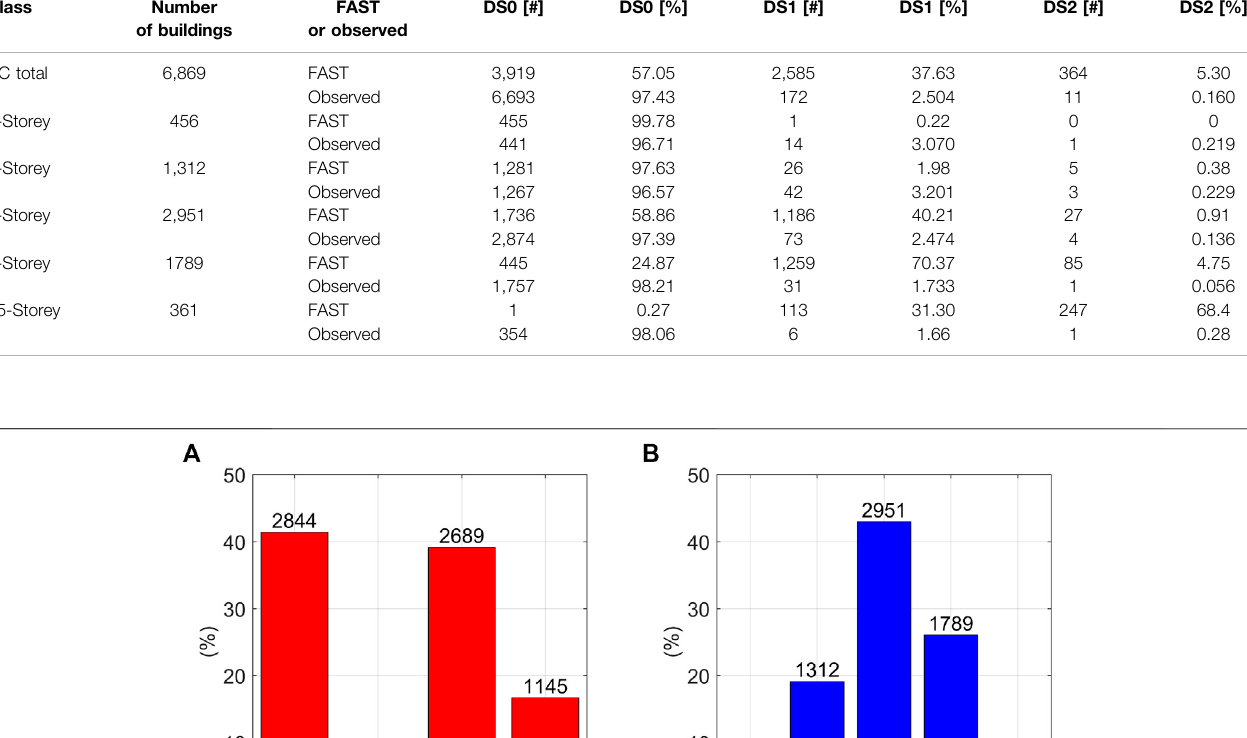
Shakya and Kawan, 2016). The ratio in-plan (LX/LY) for each building (i.e., the shape factor of the circumscribing rectangular shape around the building footprint) is obtained from the